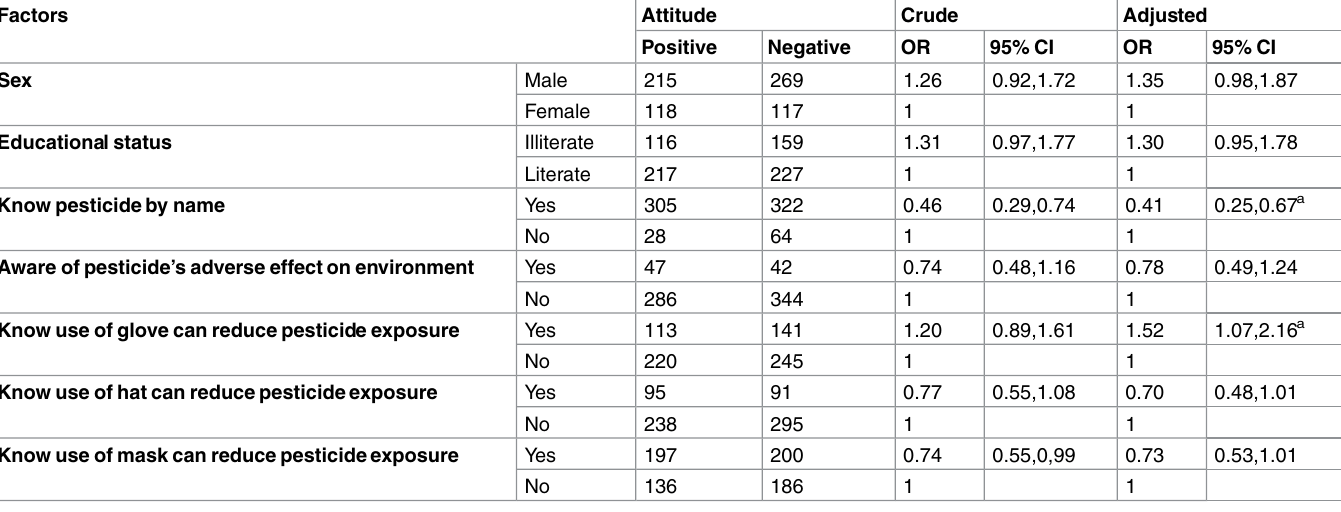
Table 5. Factors associated withattitudesof farmers towards safe use of pesticides.